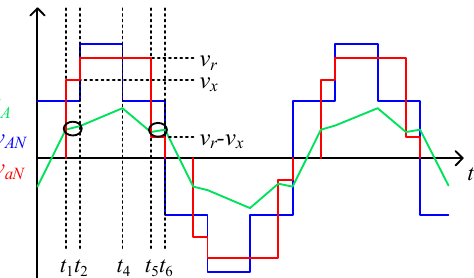
Figure 10. Operation waveform of resonant tank and transformer.